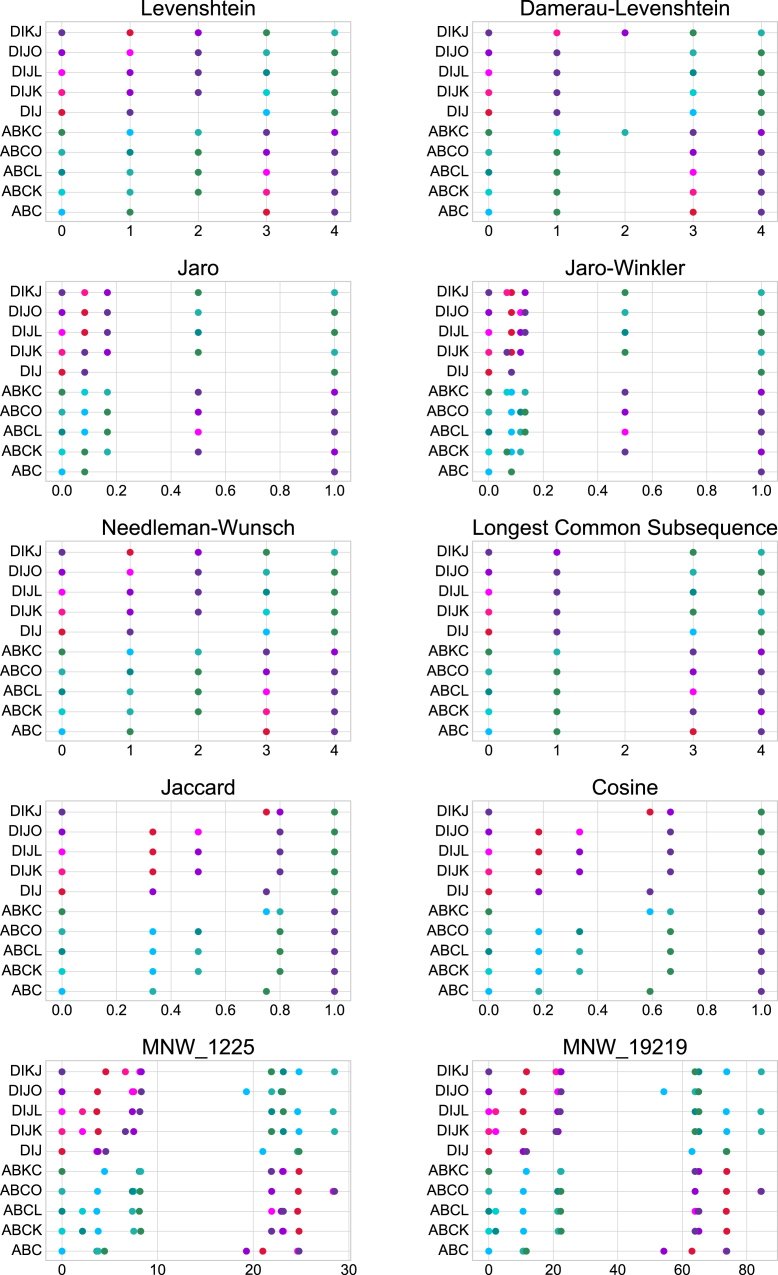
Comparison of the Ten Metrics Applied to Sample 1. (For interpretation of the references to colour in this figure legend, the reader is referred to the web version of this article.)